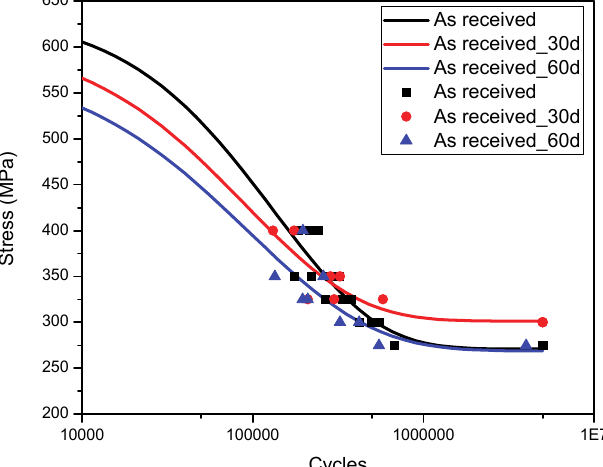
Figure 15: Fatigue results of the as-received material at all corrosion exposure periods.